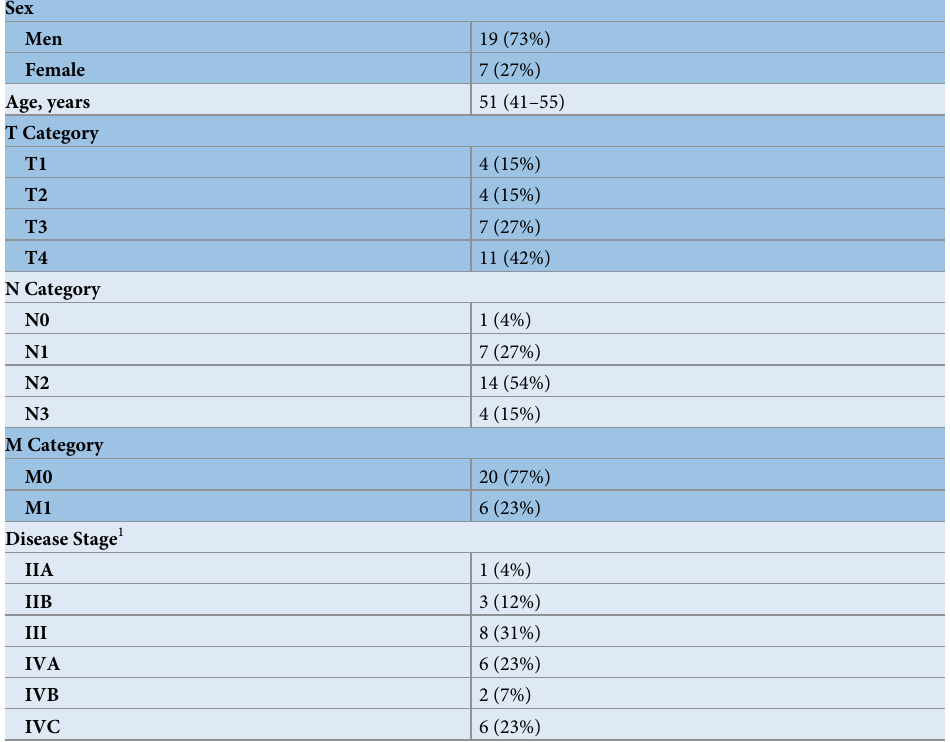
Table 1. Patient